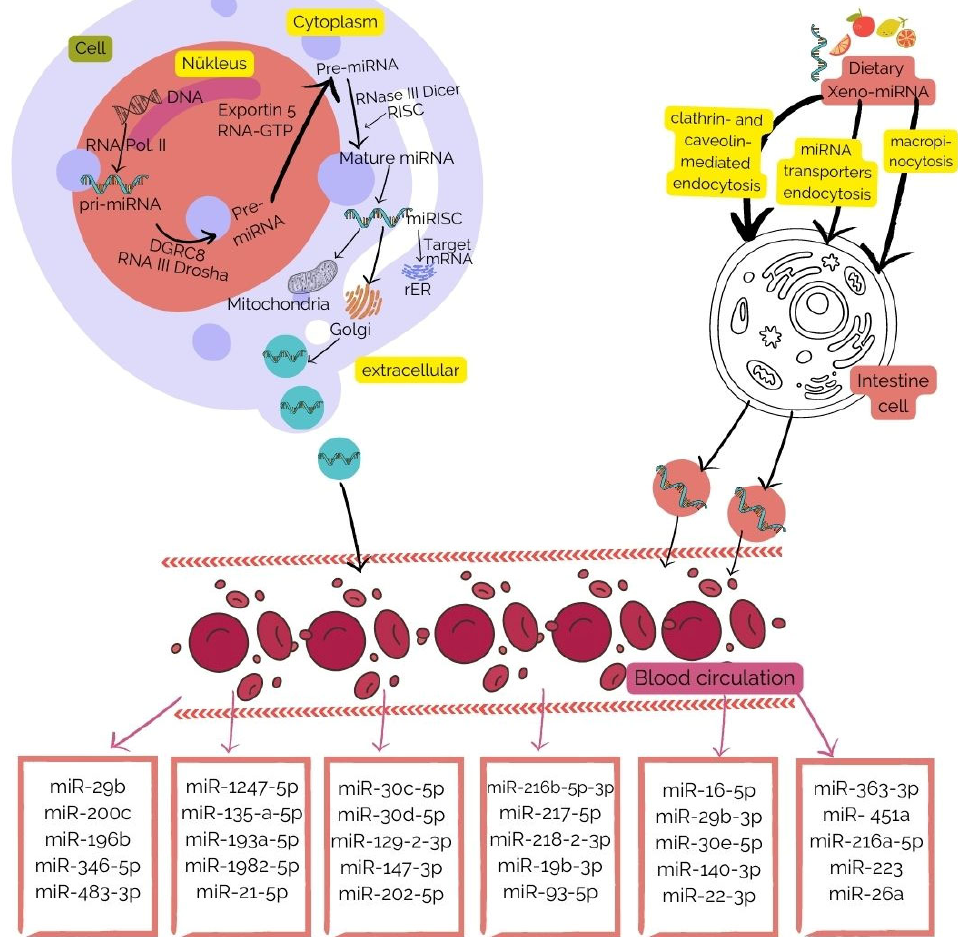
Figure 1. Schematic summary of endogenous miRNA synthesis and the incorporation of dietary xeno-miRNAs into the organism and circulation.